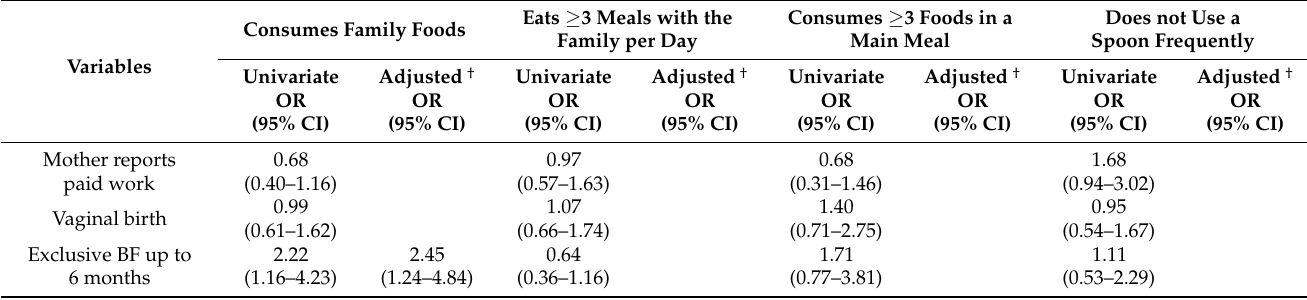
Table 4. Logistic regression models testing associations between maternal and infant characteristics, information sources on BLW and adherence to BLW